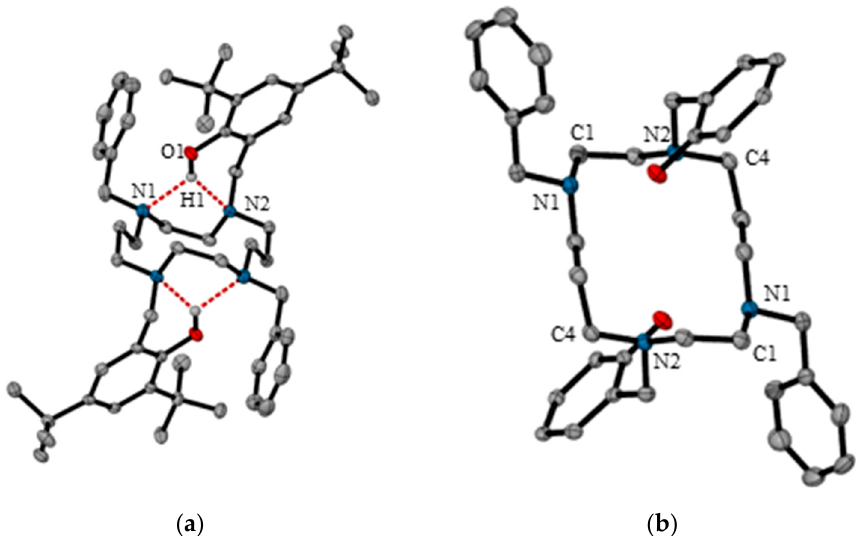
Figure 2. ( a ) Molecular structure of compound 4 with all hydrogens removed for clarity (with the exception of H1). Thermal ellipsoids are drawn at 50% probability level. Hydrogen-bonding is denoted by dashed bonds; ( b ) Conformation of the cyclam ring in compound 4 (hydrogens and tert -butyl groups omitted for clarity). C1 and C4 are located at the corners of the rectangle.